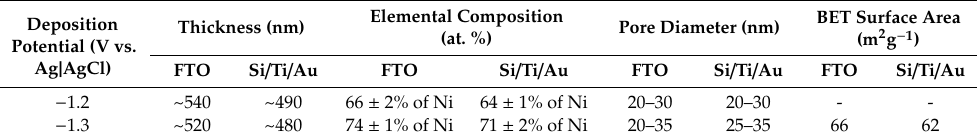
Table 2. Deposition potential, average thickness, elemental composition, pore diameter, and BET surface area of the Ni-rich Ni-Pt mesoporous films.